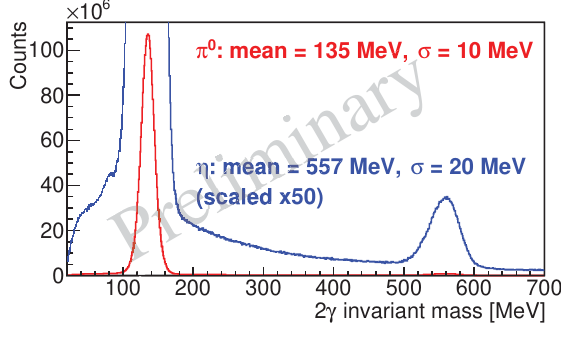
Figure 5. Neutral meson identification using the BGO Rugby Ball. The two photon invariant mass spectrum has peaks corre- sponding to the accepted π 0 and η masses. Approximate mean and sigma values given inset.